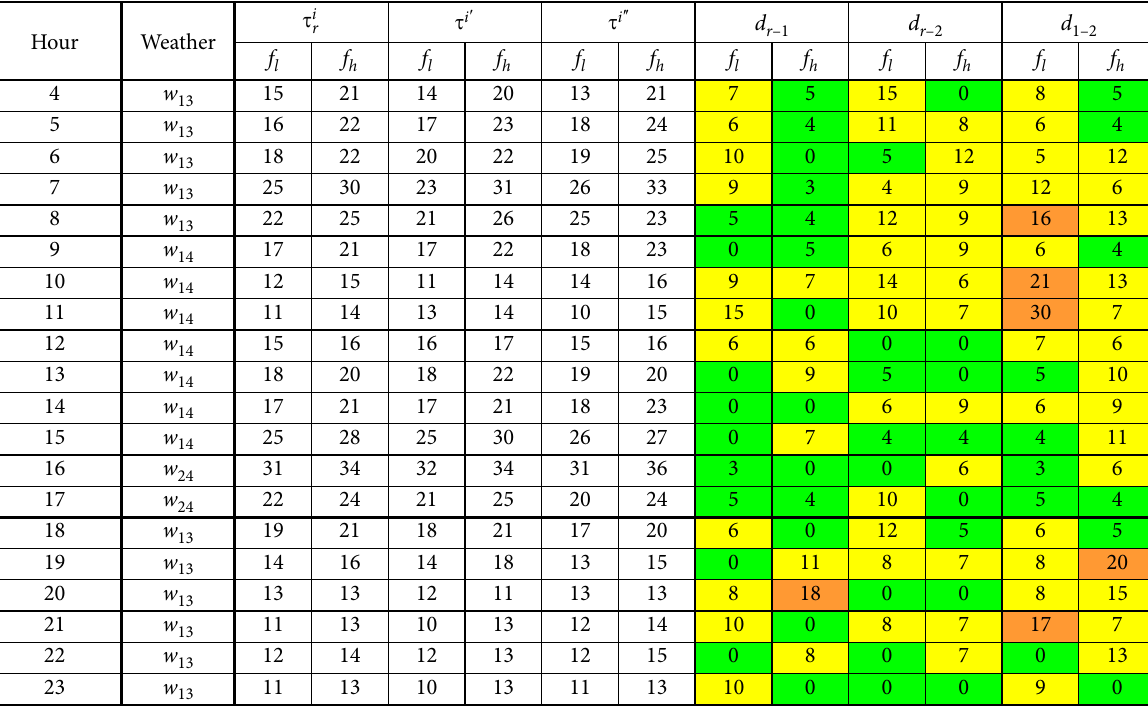
Table 9. Results [s] calculated with Method I (part) – tor) and for the given floor height (4th influencing fac- clustering according to three criteria at the selected stop tor). Due to space limitations, only one correction factor ( source : research by the authors) from each type is calculated in detail, the others can be formed in a similar way. Weather Weather correction factor for cold and dry condi- tion (weather category 11): τ = Floor height correction factor for low height: τ = = . Table 10. Average dwell times at the given stop for different time intervals [s] (part) ( source : research by the authors) Tables 6 and 7 contain the values for the quotients. Hour Average dwell time τ i After the determination of input parameters, it is pos- t sible to calculate the dwell times for the circumstances when Method I cannot provide any result due to the lack of data. At the selected stop ( i = Tihanyi Árpád út kórház ), in the 15–16 h time interval ( t = 15), in the case of cold and dry weather category w and in the case of low 11 floor vehicles ( f ) the calculated dwell time is: l Table 11. Results [s] calculated with Method II (part) ′′τ = τ ⋅ . ( source : research by the authors) Weather Values for each time period, weather category and Hour floor height can be calculated in a similar way. Table 11 contains the results calculated by Method II (based on the correction factors). Calculation can be performed in the same way for the other stops. 16 In order to verify the methods, the relative errors 17 d , d and d have been determined for a given stop r –1 r –2 1–2 ( i = Győr , Városháza ) with major passenger traffic by Table 12. Recorded (real) and calculated dwell times and relative errors ( source : research by the authors) τ i r d Hour Weather